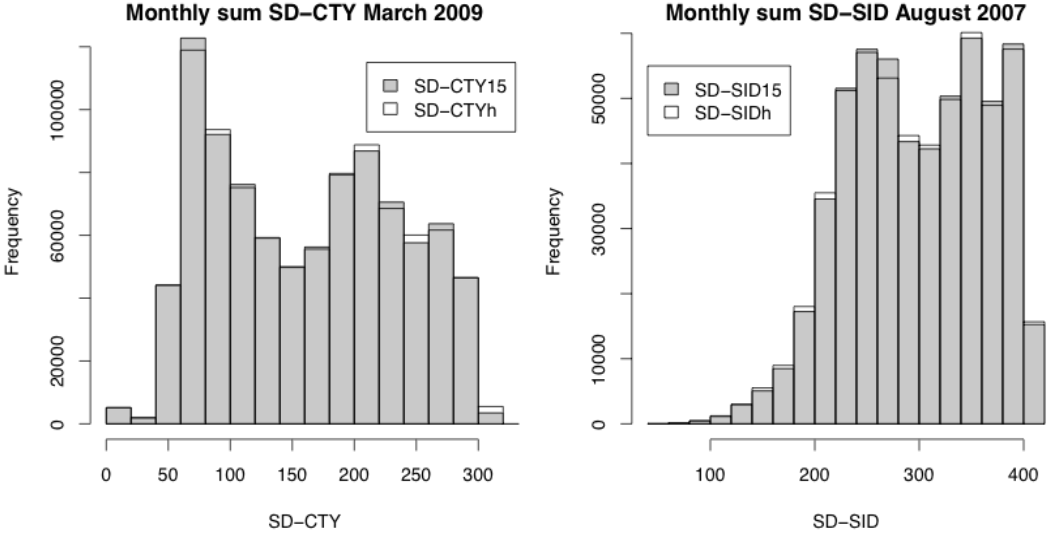
Figure 2. Comparison of frequency distributions for 15-min data and 1-hourly